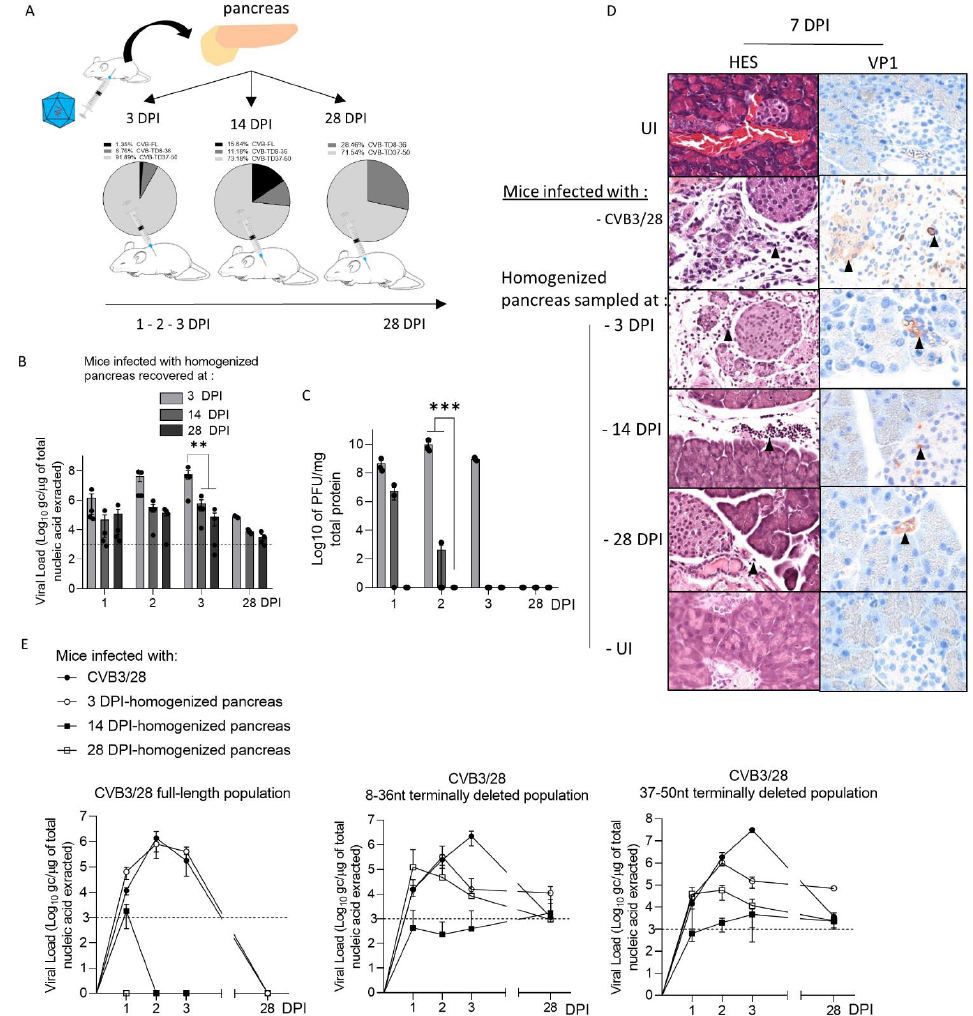
Figure 2. Inoculation of CVB RNA pancreatic populations in DBA/2J mice induced acute and persistent infections with capsid viral protein 1 expression. ( A ) Schematic representation of the experimental procedure. Pancreases were sampled after 3, 14 or 28 days of CVB3/28 infection, and were then homogenized and clarified. Supernatants were inoculated by the intra-peritoneal route to uninfected mice. ( B ) CVB3/28 RNA loads, extracted from pancreases of mice inoculated with 3, 14 or 28 DPI-infected pancreases, were quantified by RT-qPCR ( n = 4, each dot represents one mouse). ( C )